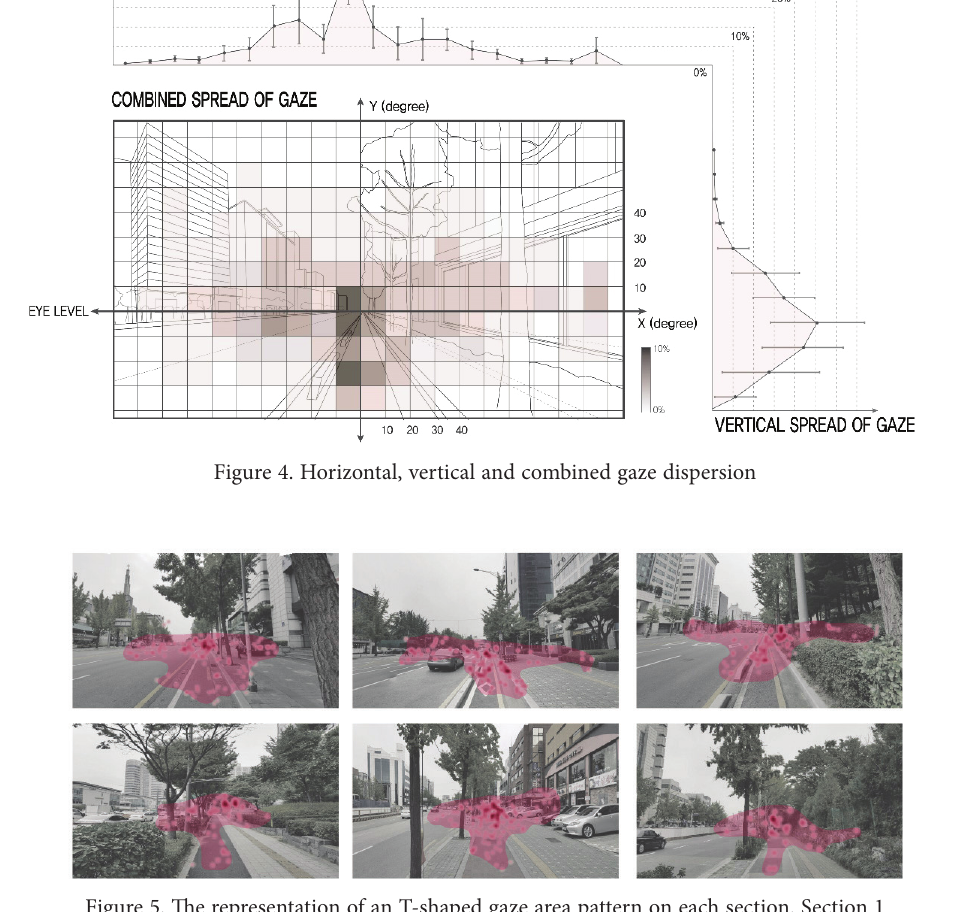
Figure 5. The representation of an T-shaped gaze area pattern on each section. Section 1 (upper left), Section 2 (upper middle), Section 3 (upper right), Section 4 (bottom left), Section 5 (bottom middle) and Section 6 (bottom right) Table 2. Mean values and standard deviations of fixation duration percentage (%) for each road